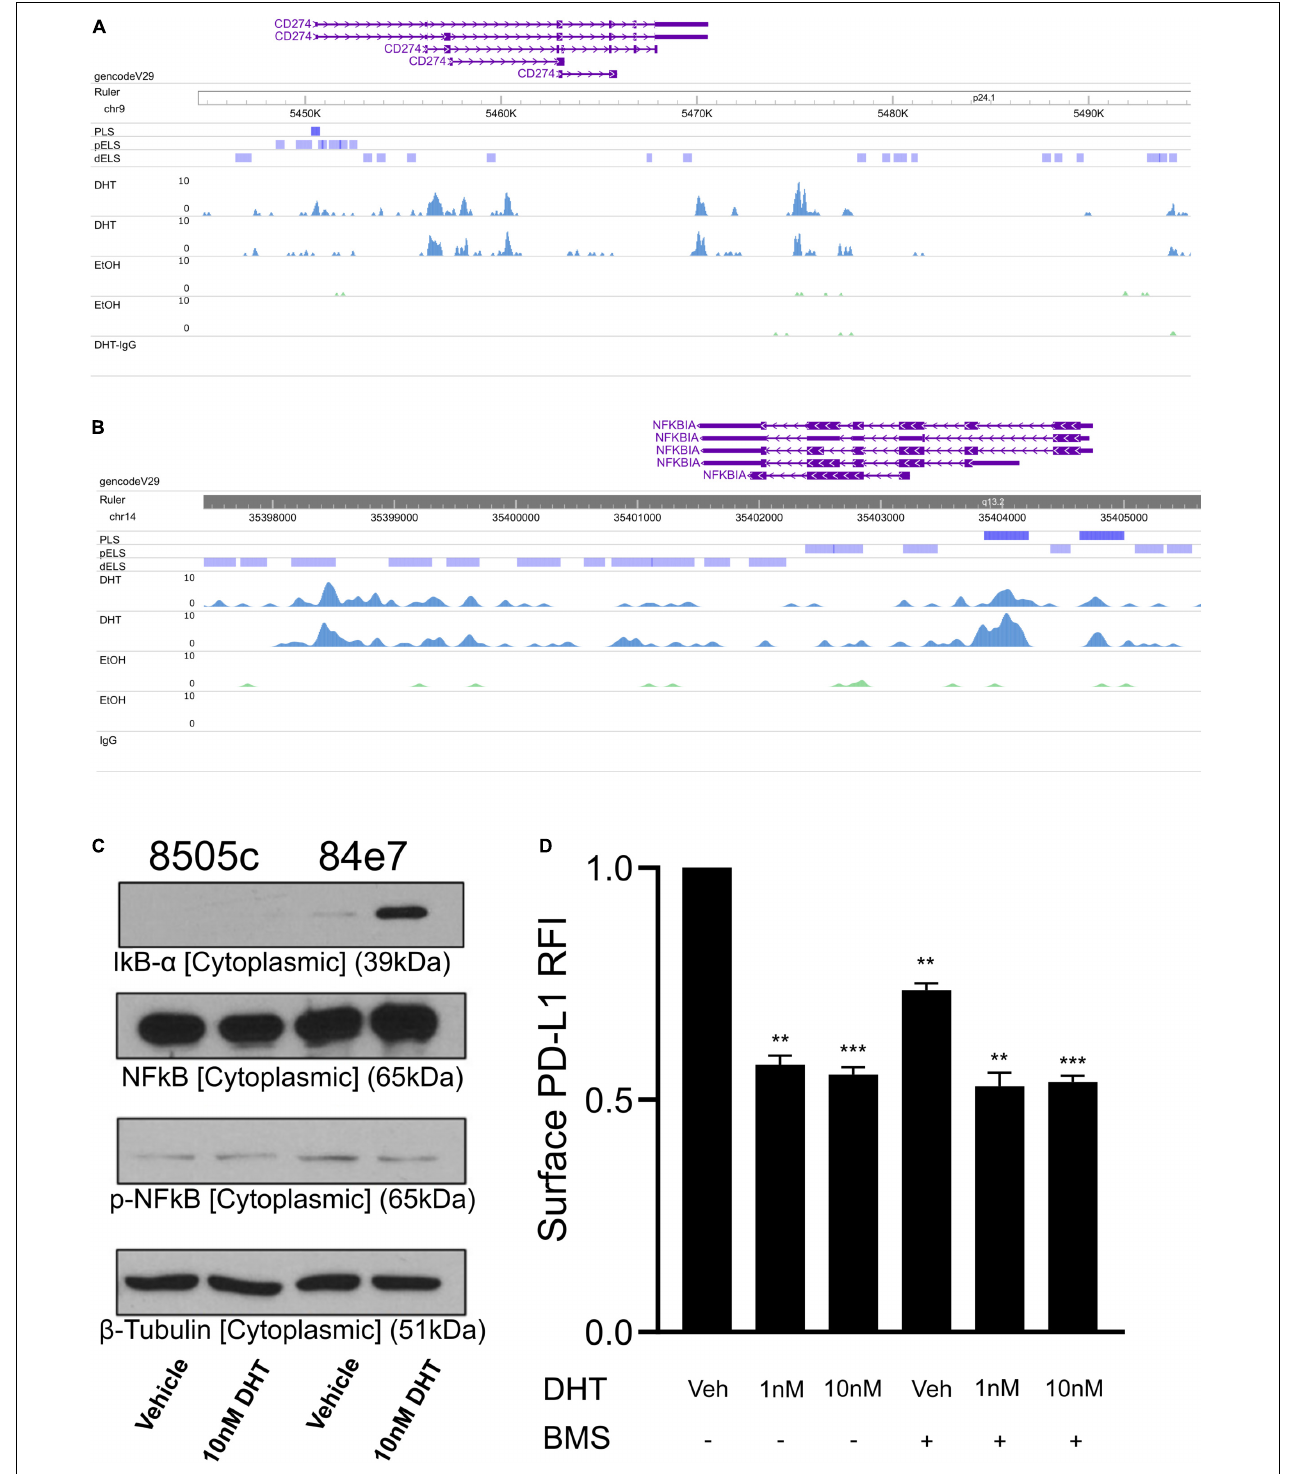
FIGURE 3 | Profiling AR binding genome-wide in 8505C-AR cells. CUT&Tag AR signal at the CD274 gene body (A) and the NFKBIA gene promoter (B) . (C) Western blot analysis of cell cytoplasmic fraction from 72 h vehicle and 10 nM DHT-treated 8505C and 84E7. (D) Surface PD-L1 expression in 84E7 cells co-treated with 10 nM DHT for 48 h and the IKK inhibitor BMS-345541 (BMS) at 10 µ M for 24 h. PLS, promoter-like signal; pELS, predicted enhancer-like signal; IgG, isotype control IgG CUT&Tag. Student t -tests paired to control conditions ** p < 0.005 and *** p < 0.0005.